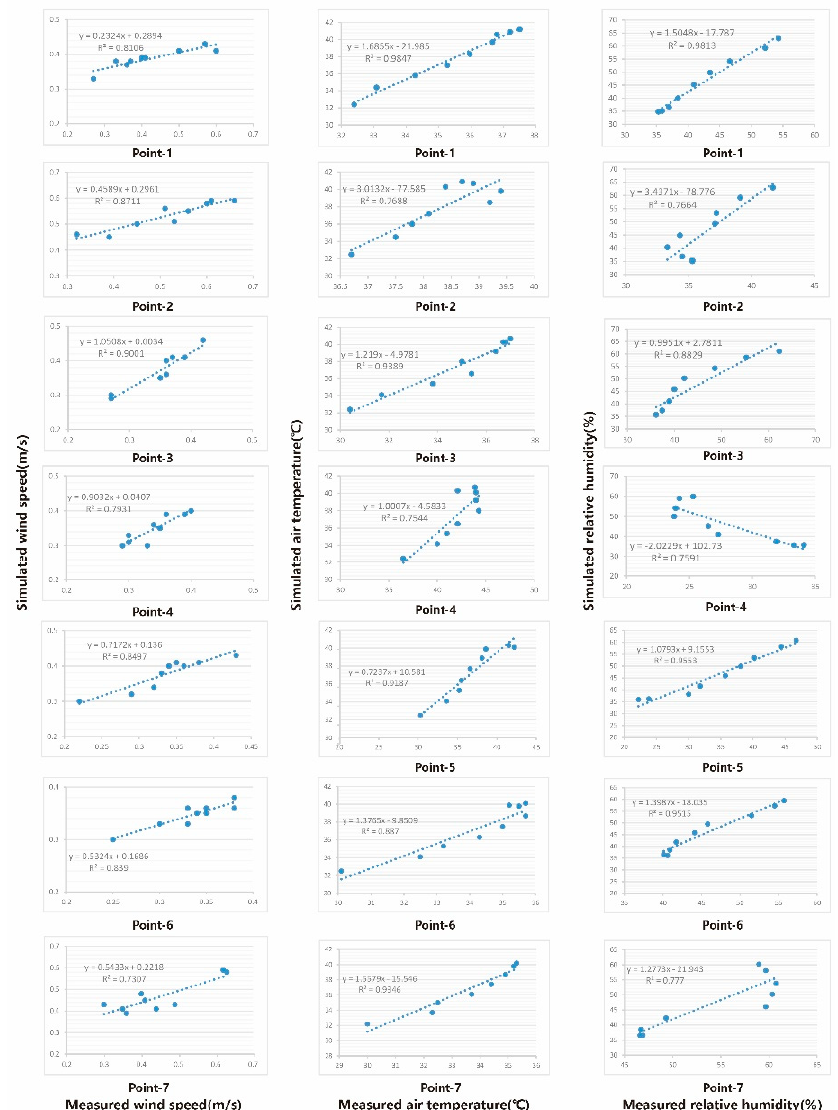
Figure 14. The correlation between three kinds of data on 24 July 2016. Table 5. The new scenarios.